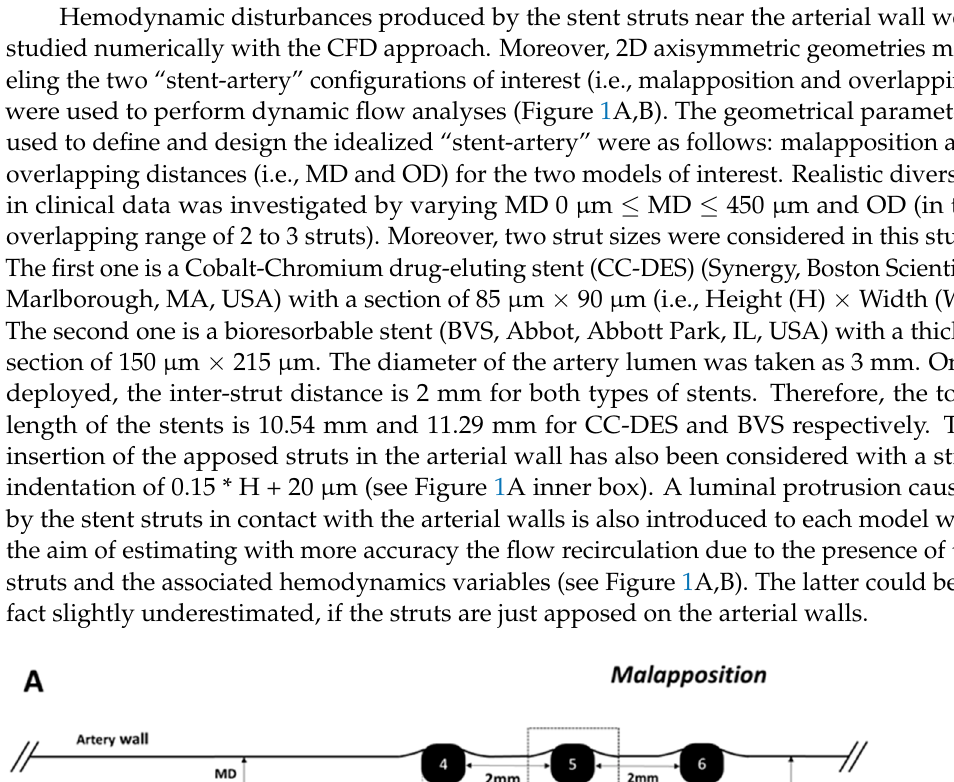
Figure 1. ( A ) Single stent geometry with three malapposed struts (# 1, 2, and 3) and three correctly apposed struts (# 4, 5, and 6) and ( B ) two overlapping stents (first stent: struts # 1 to 6, second stent: struts # I to (VI) and ( C ) 3 overlapping configurations, with two congruent struts, with in- congruent struts and three congruent struts. 2.1.2. Studied Malapposition Configurations This strut configuration is displayed in Figure 1A. It illustrates one stent with three misaligned struts and three correctly apposed ones. The MD of the first three struts was between 0 and 450 µm for both stents (i.e., CC-DES and BVS). The three apposed struts were placed downstream and remained fixed for all simulations. The following configu- rations were studied: for the CC-DES: MD = 0, 40, 60, 80, 115, 130, 150, 180, 225, 300 and 450 µm (i.e., n = 11 cases), and for the BVS: MD = 0, 40, 80, 115, 150, 180, 225, 300 and 450 µm (i.e., n = 9 cases). When MD = 0 µm the six struts are correctly apposed (i.e., total stented artery length of 10.54 and 11.29 mm for CC-DES and BVS, respectively), these two